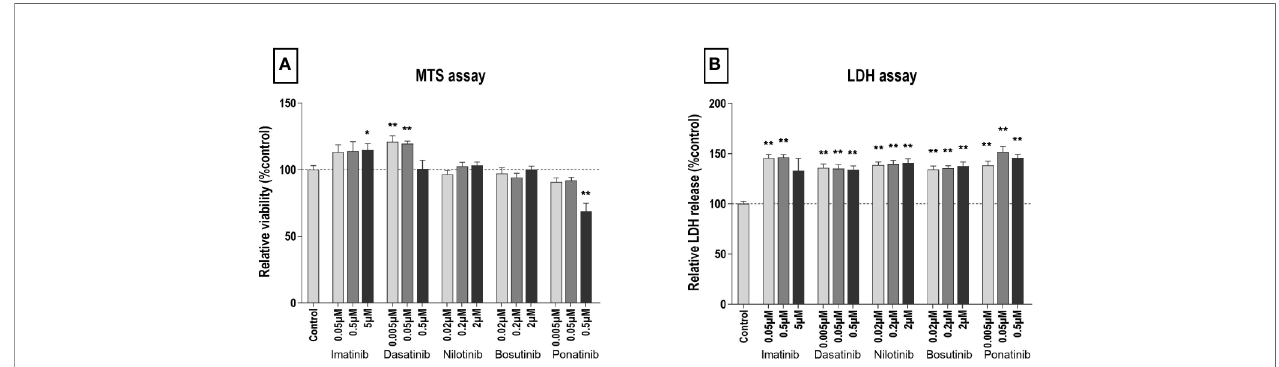
FIGURE 1 | All BCR-ABL TKIs induce HUVEC membrane damage after 72 h. MTS (A) and LDH (B) assays were performed on HUVECs exposed for 72 h to the indicated BCR- ABL TKI in medium with 10% dialyzed FBS. Data are presented as means ± SEM of n = 9 of three independent experiments (N = 3). Results are expressed relative to control (DMSO 0.2%). Differences between conditions were tested using the Wilcoxon signed rank test that compared the effect of each TKI condition versus control. *p < 0.05 and **p <